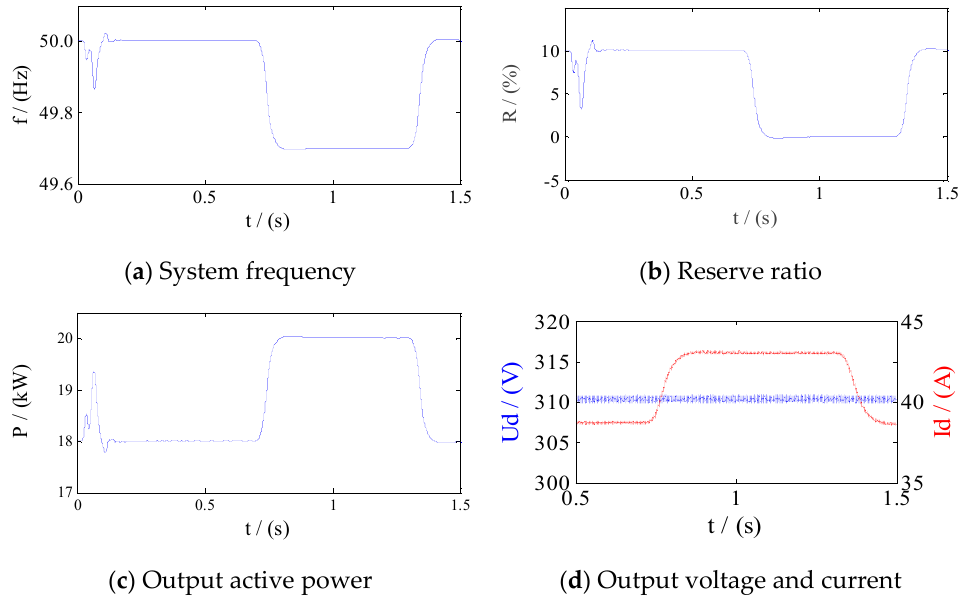
Figure 9. System output waveform when frequency decreases by 0.3Hz.